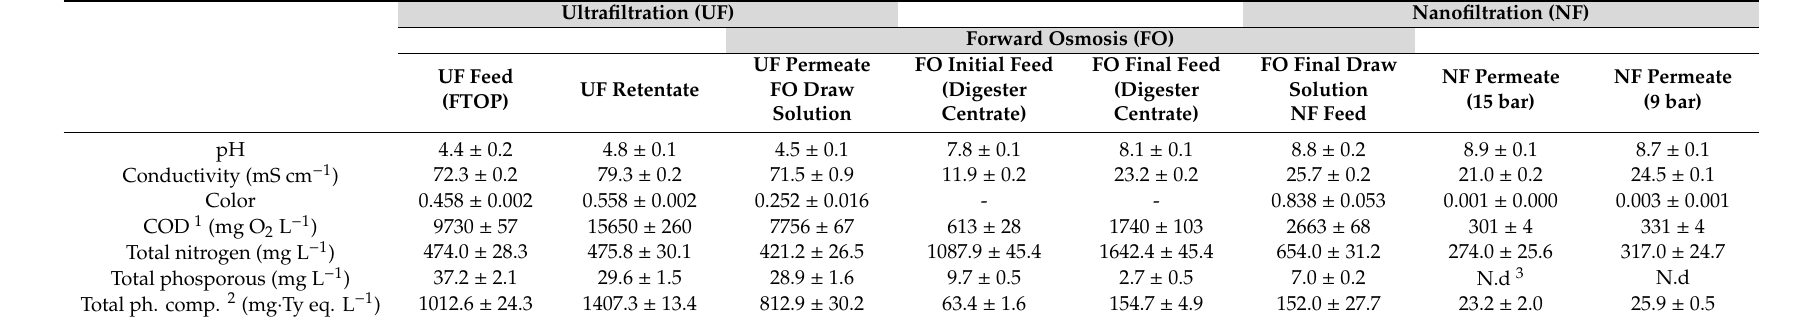
Table 1. Characterization of the di ff erent streams (FTOP: residual fermentation brine from table olive